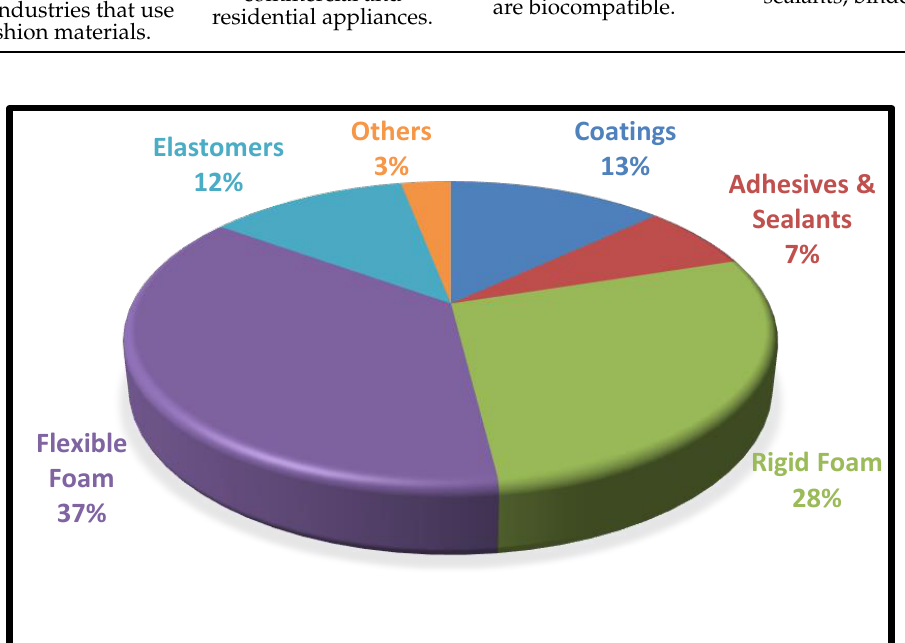
Figure 2. Global Consumption of PUs in Different Sectors.